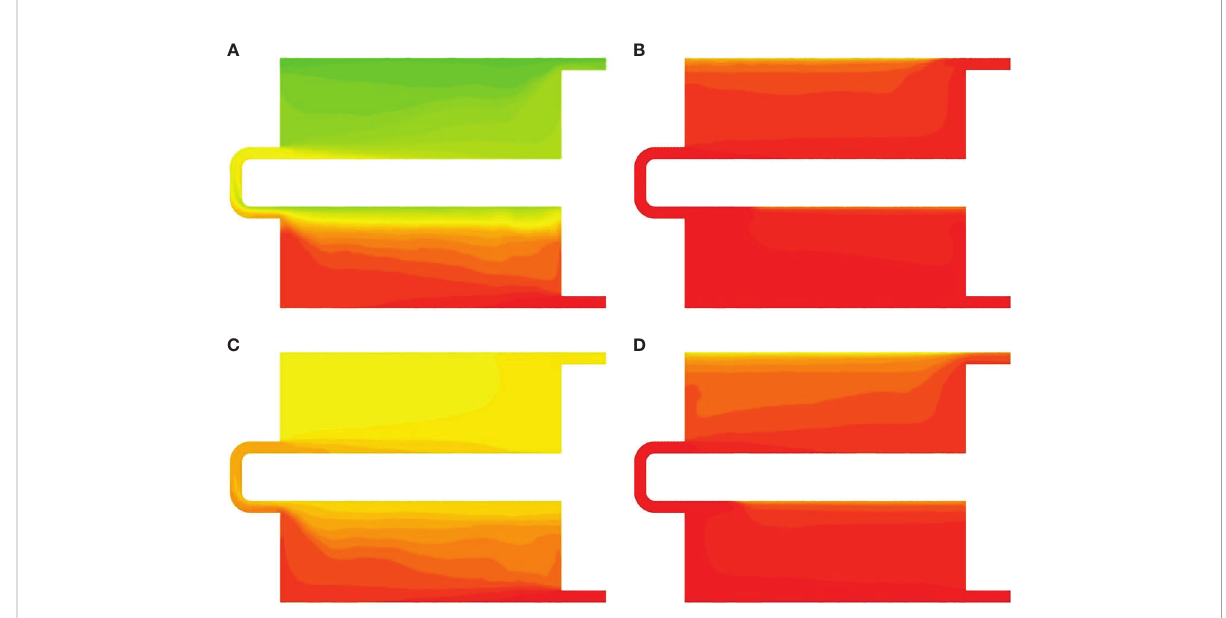
FIGURE 5 The concentration distribution of the solution when the sample in fl ow velocity is 0.1m/s, (A, B) The double displacement, (C, D) The triple